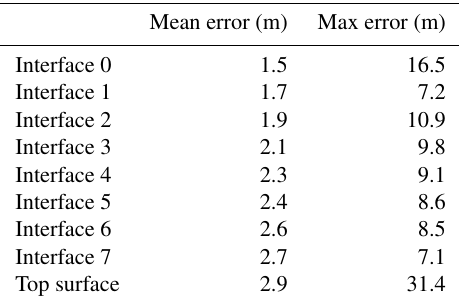
Table 1. Mean and maximum errors for the restoration of each in-